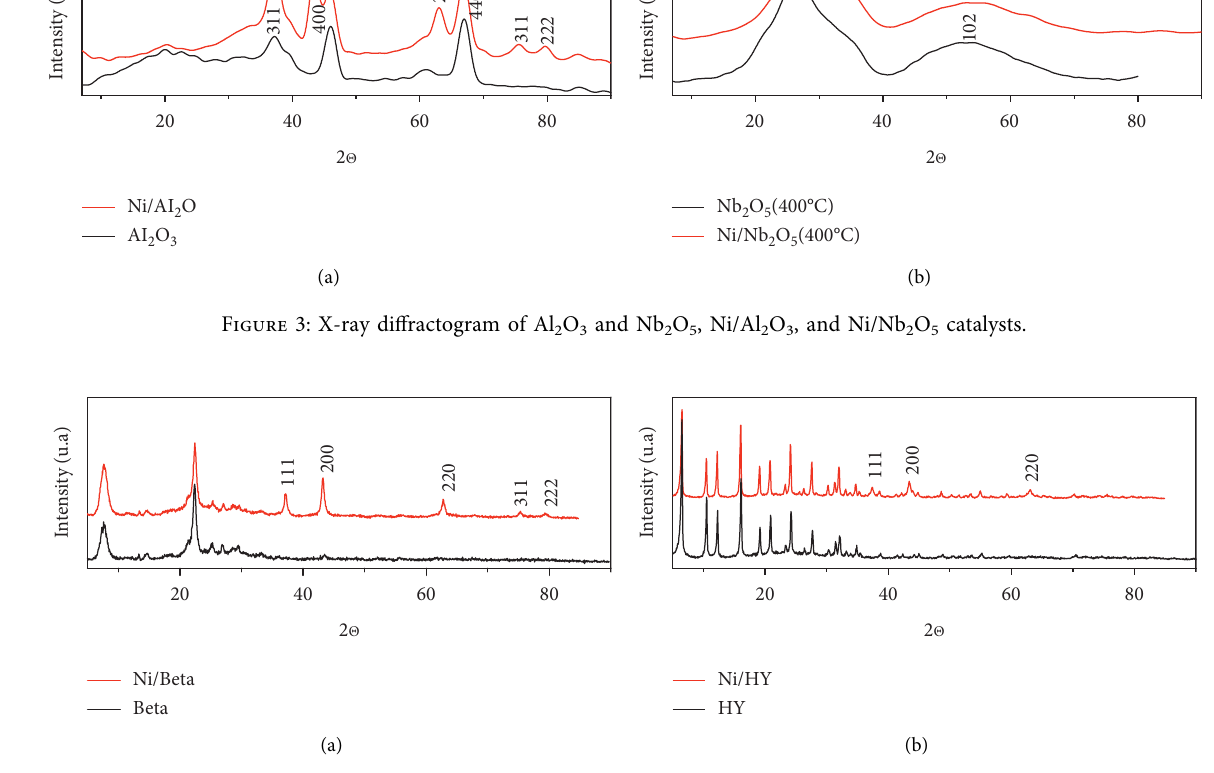
Figure 4: X-ray diffractogram of Beta HY, Ni/Beta, and Ni/HY catalysts. Table 2: Chemical composition of the prepared catalysts (wt%) after impregnation.